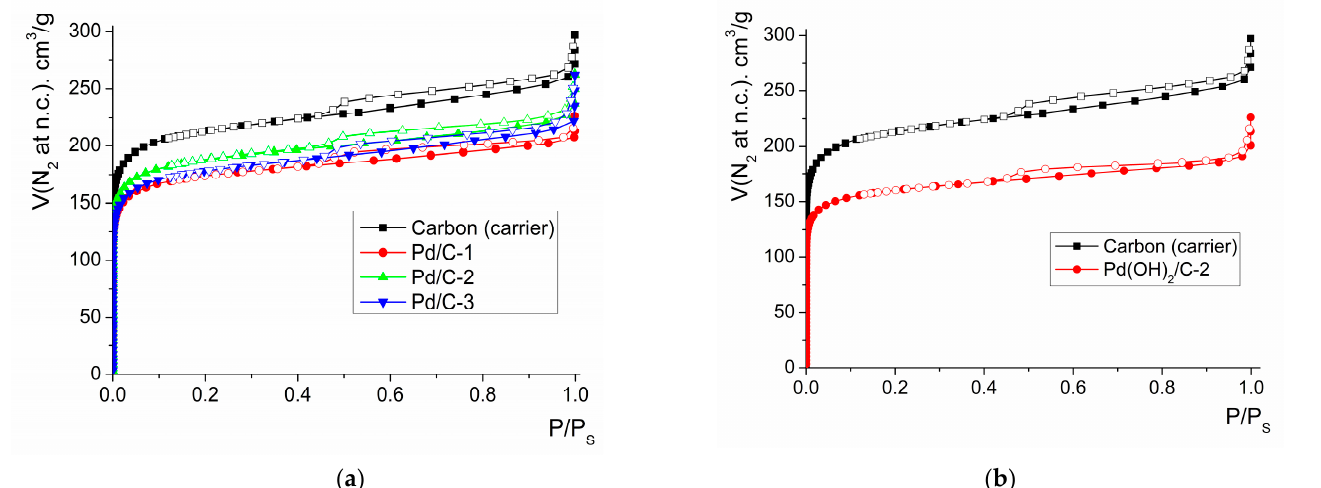
Figure 9. Isotherms of N 2 adsorption (filled points) and desorption (empty points) for Pd/C composites ( a ) and Pd(OH) 2 /C-2 composite ( b ) at 78 K.